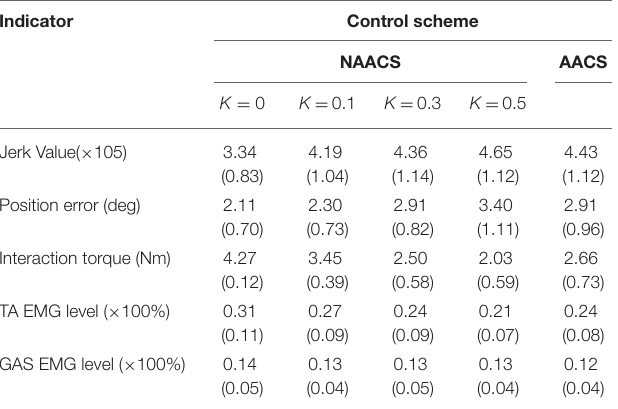
TABLE 2 | The mean (standard deviation) of jerk value, position error, interaction torque, TA EMG level, GAS EMG level under different control schemes ( n trials).